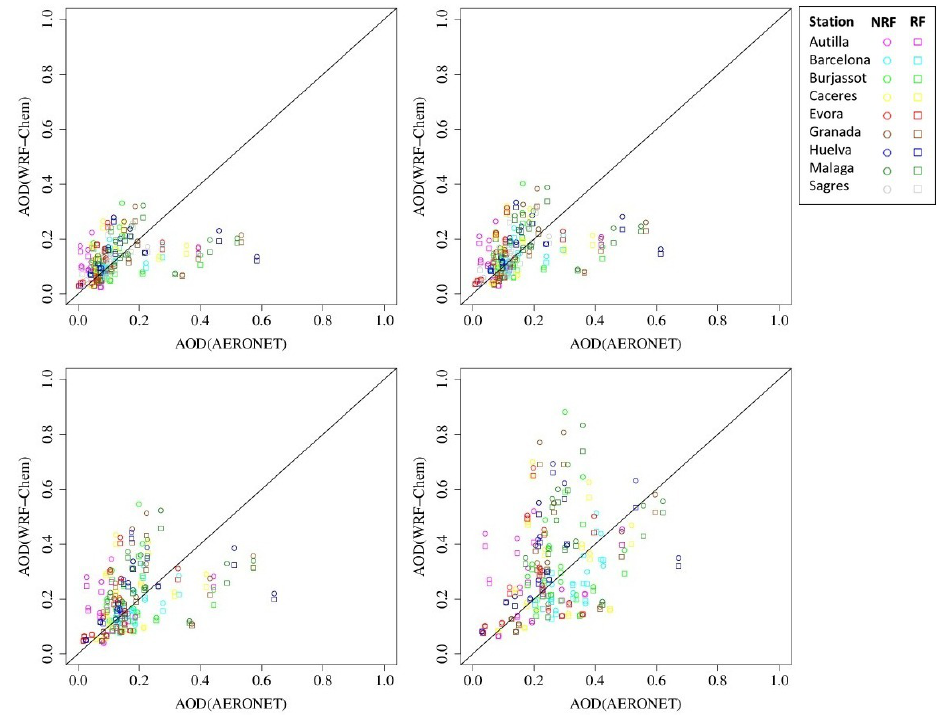
Figure 8. Linear regression between AERONET ( x ) and simulation daily data ( y ; NRF in circles and RF in squares) for the dust episode (from 28 June to 12 July): AOD 1020 (top left), AOD 870 (top right), AOD 675 (bottom left) and AOD 440 (bottom right).